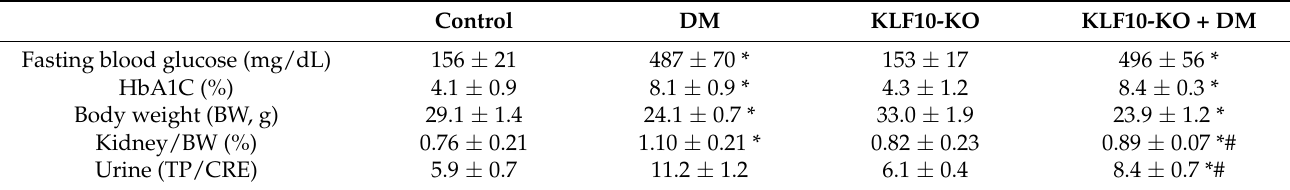
Table 1. The biochemical properties of experimental animals (n = 6).